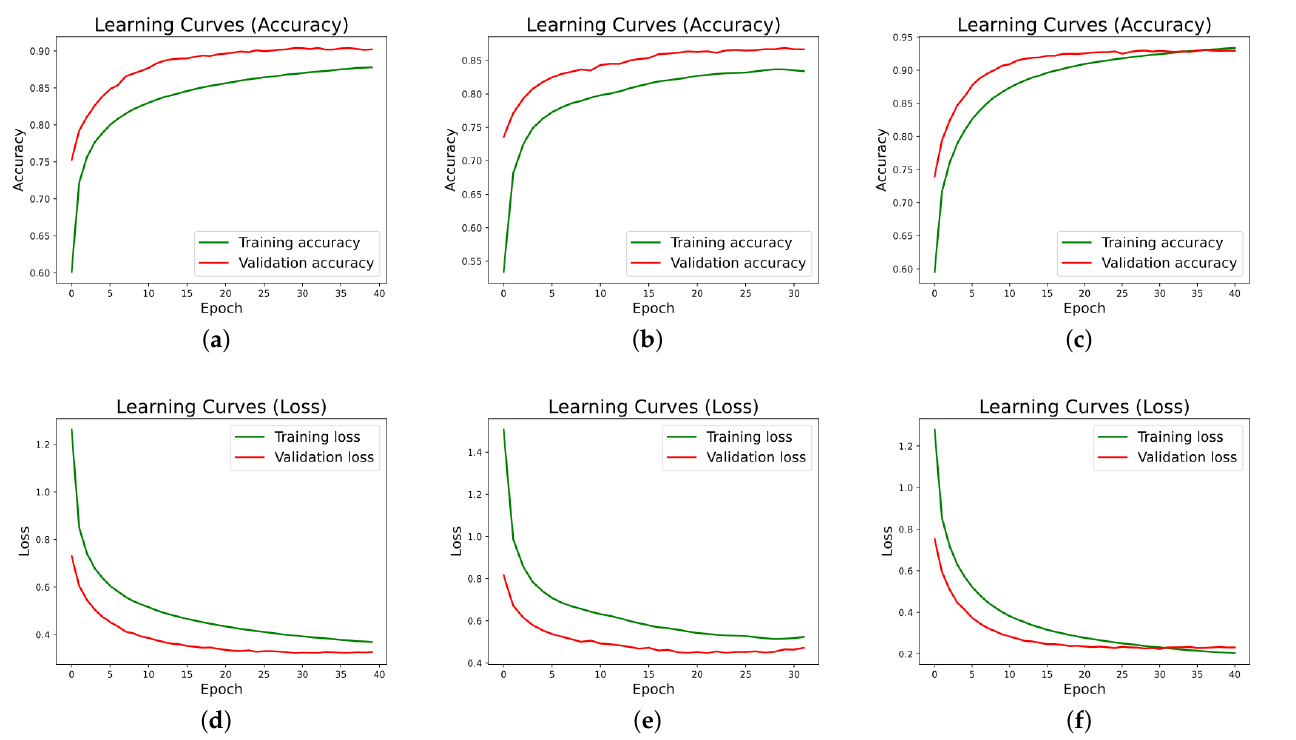
Figure 9. Neural network training graphs for user 1. ( a ) Model RNN Accuracy User 1, ( b ) Model LSTM Accuracy User 1, ( c ) Model GRU Accuracy User 1, ( d ) Model RNN Loss User 1, ( e ) Model LSTM Loss User 1, ( f ) Model GRU Loss User